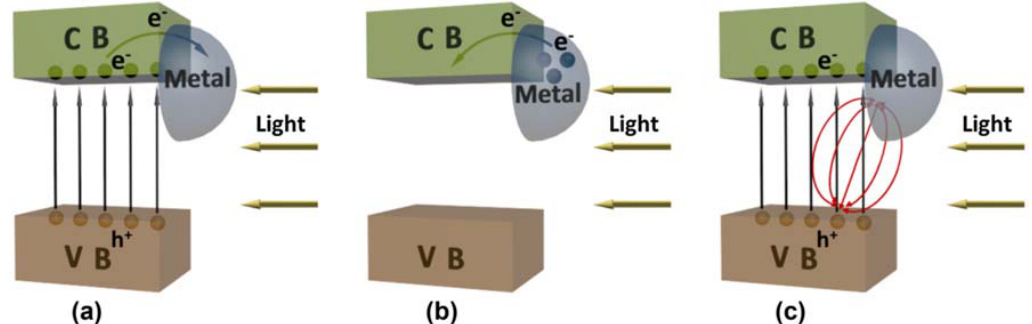
Figure 19. Schematic diagram showing: ( a) transfer of electrons to form a Schottky barrier ( b ) transfer of electrons excited by surface plasmon resonance, ( c ) excitation of electrons in the photocatalyst from the local electric field. Reproduced from Ref. [170] with the permission from the Elsevier.